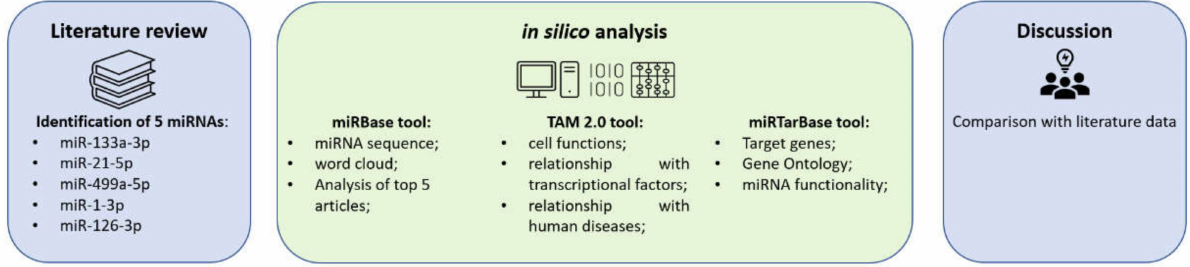
Figure 10. The workflow adopted to perform this in silico